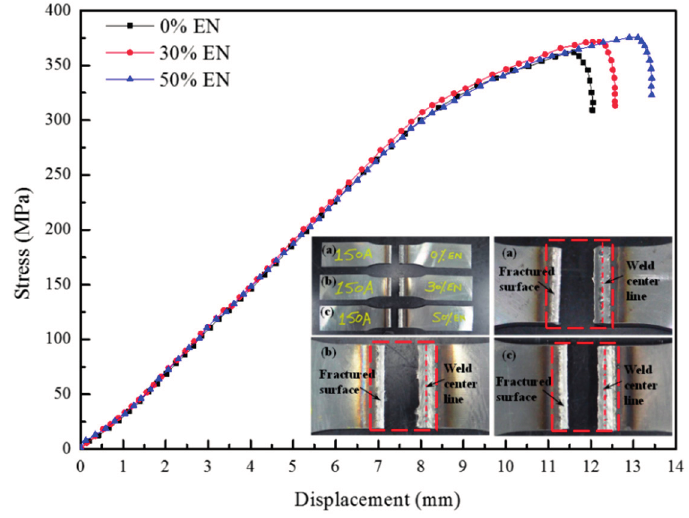
Figure 12. Stress vs. displacement at Ia of 150 A. The inset shows the fractured surfaces of the tested samples.